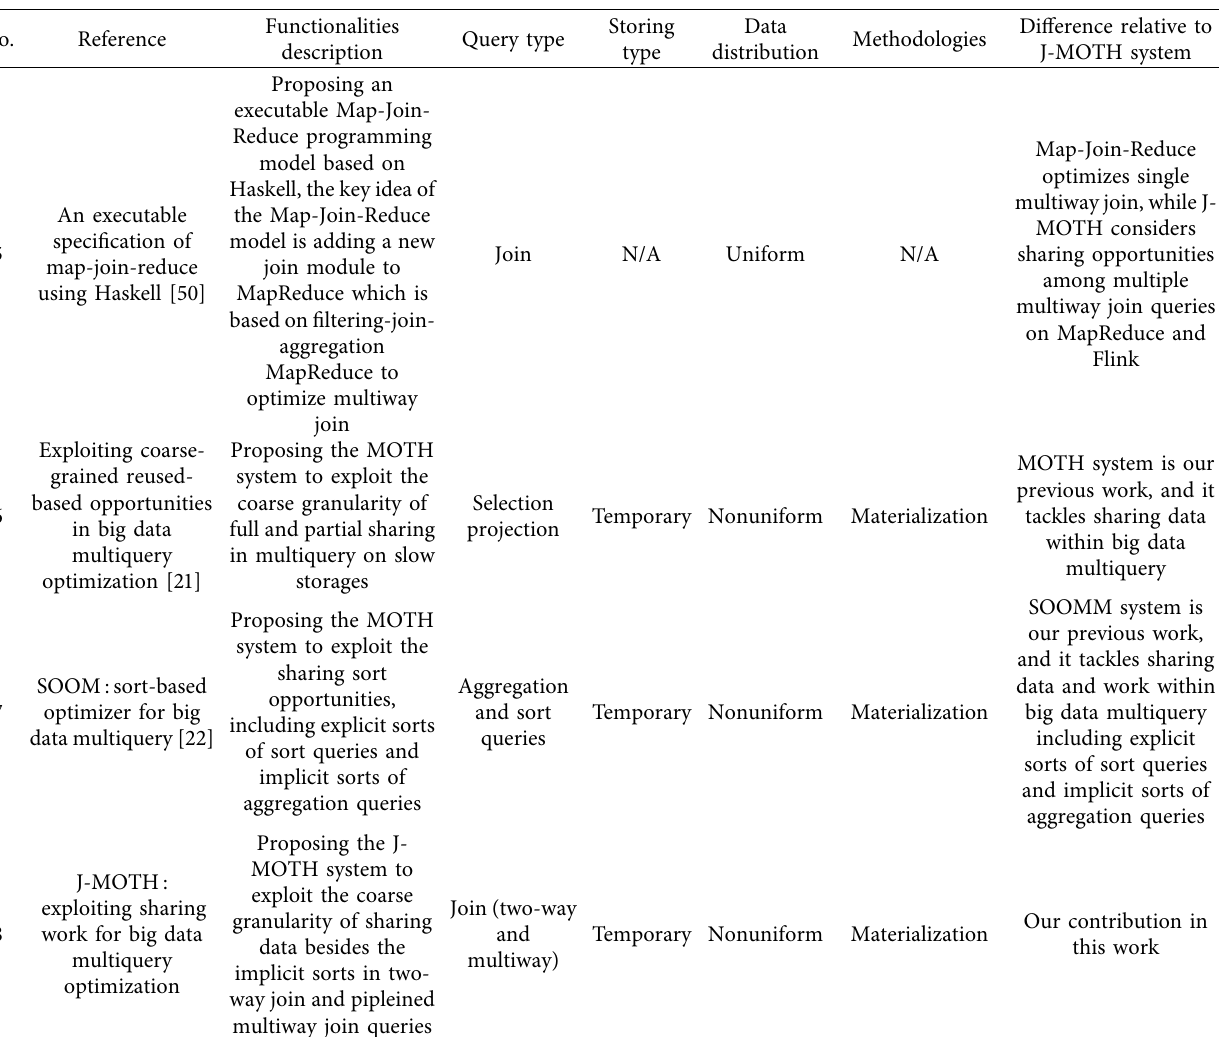
Algorithm 1–3 for the J-MOTH optimizer, refining shared multiquery and updating weight,